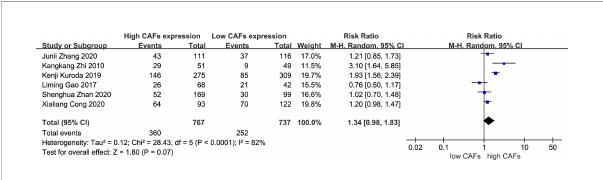
FIGURE 8 Correlation between CAFs and tumor size in gastric cancer. CAF, cancer-associated fi broblast; CI, con fi dence interval.